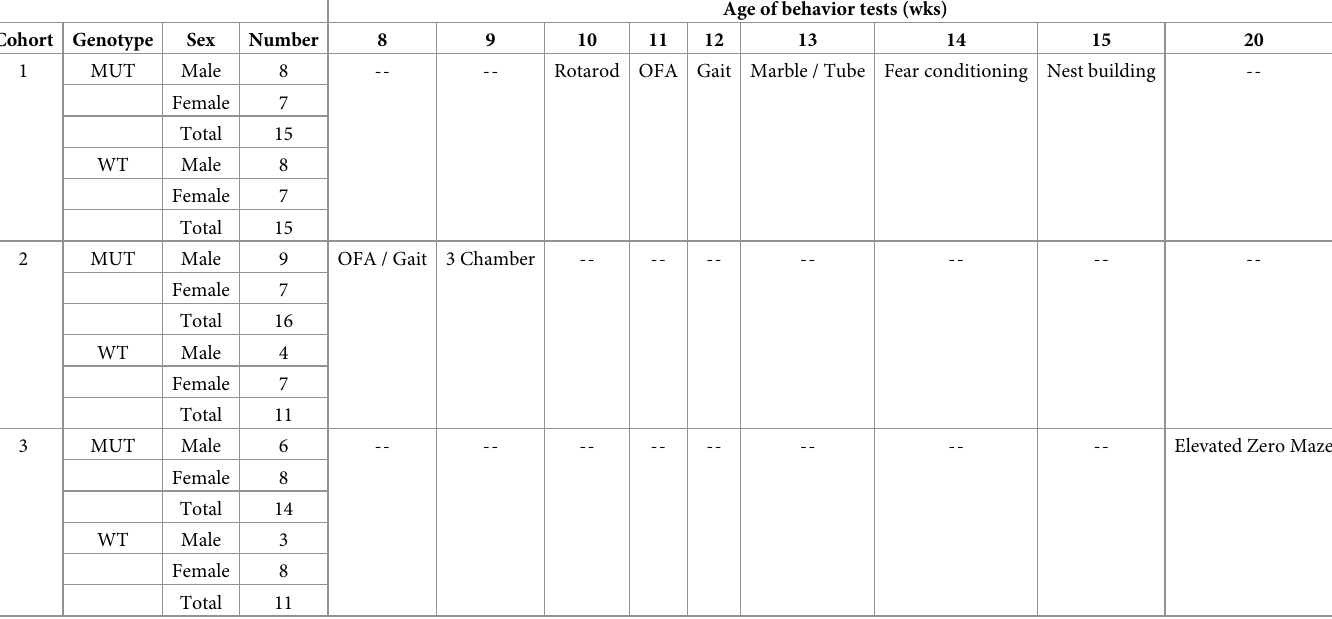
Table 1. Cohorts of animals used in behavioral testing. Abbreviation: OFA-Open Field